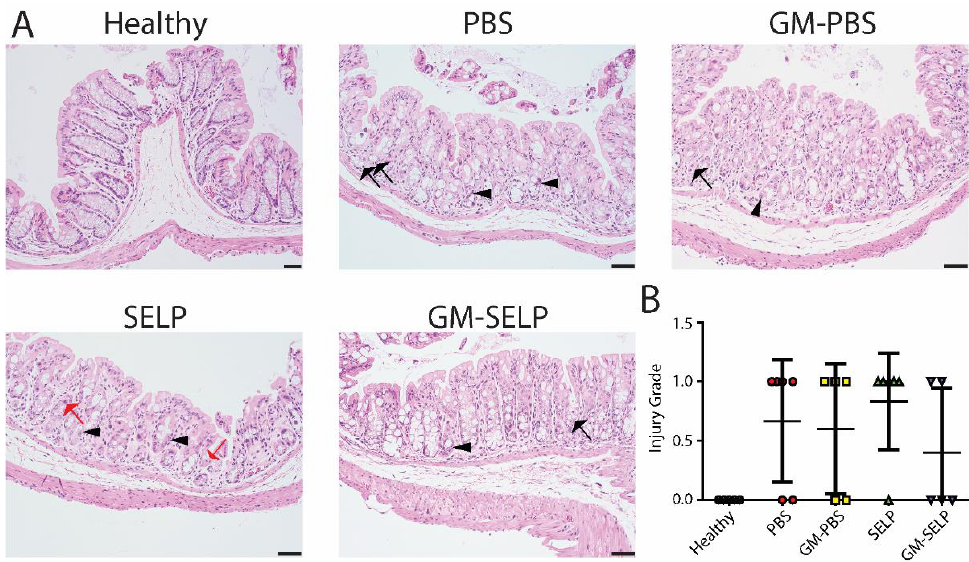
Figure 2. Histological analysis of tissues 3 days following irradiation. ( A ) Histological sections of healthy and irradiated animals receiving selected treatments. Black arrows indicate apoptosis, arrowheads indicate epithelial cell pleomorphism, and red arrows indicate mitoses. ( B ) Blinded scoring of histological sections to determine injury score.